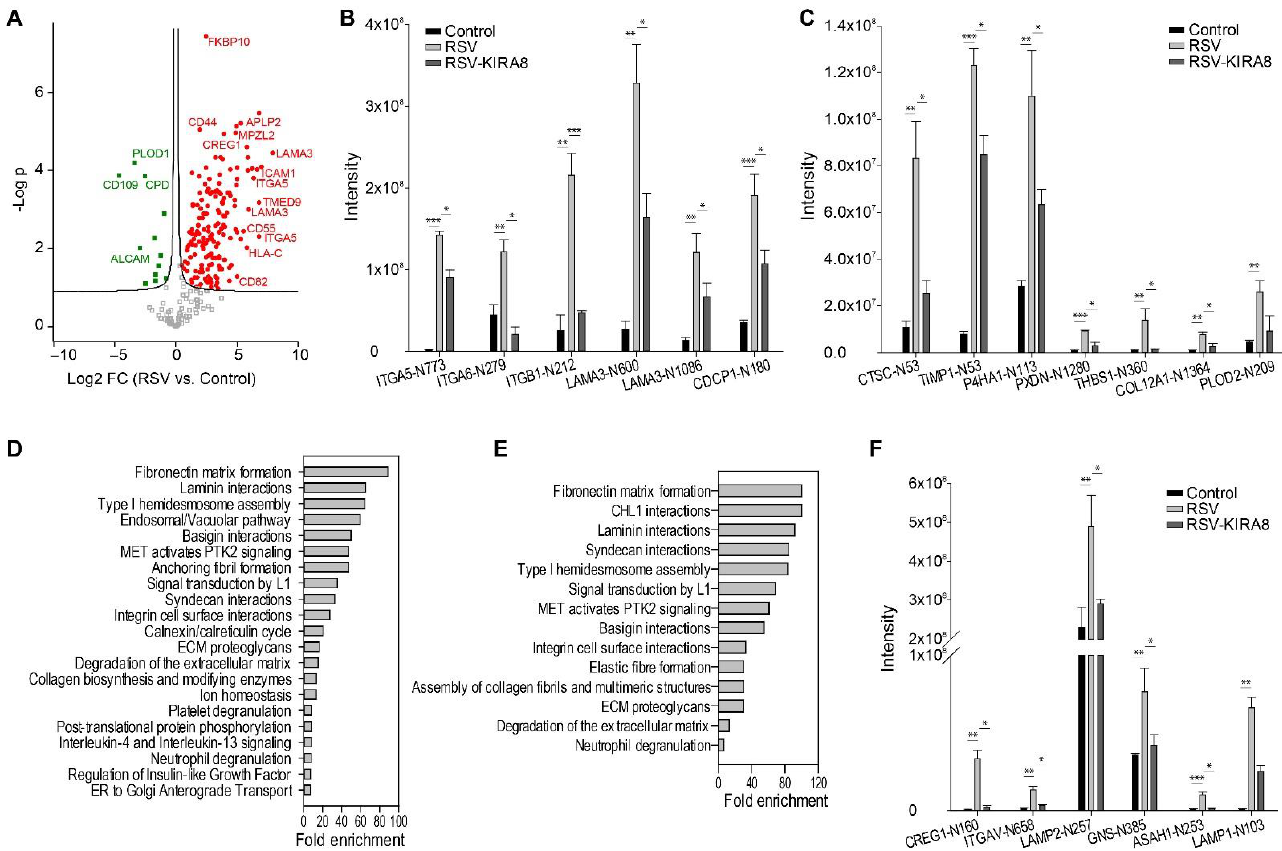
Figure 3. Proteomics analysis of N-glycosylation in hSAECs infected with RSV in the presence or absence of KIRA8. hSAECs were infected with RSV at 1.0 MOI for 24 h in the presence or absence of KIRA8 (10 µM). The N-glycosylated peptides were enriched with lectins and then analyzed with label-free LC-MS/MS. ( A ) Volcano plot of N-glycosylated peptides (RSV vs. Control). Red circle, N-glycoproteins upregulated by RSV; green square, N-glycoproteins downregulated by RSV infection. ( B , C ) Some N-glycosylated peptides strongly induced by RSV infection and regulated by the IRE1 α – XBP1 arm of UPR are shown (Student’s t -test with permutation FDR < 0.05). ( D ) Panther Reactome pathways activated by RSV infection (FDR < 0.05%). ( E ) Panther Reactome pathways activated by RSV infection and attenuated by KIRA8 (FDR < 0.05%). ( F ) N-glycosylation of proteins involved neutrophil degranulation, which was regulated by the IRE1 α –XBP1 arm of UPR. Student’s t -test with Permutation correction, *, q < 0.05, **, q < 0.01, ***, q <